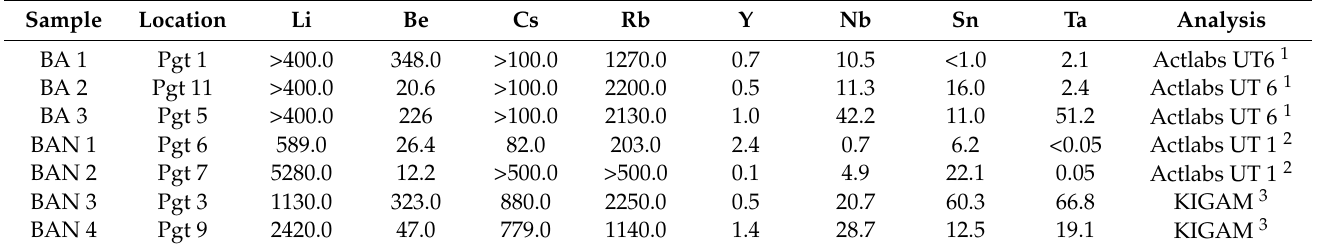
Table 1. Rare-element composition (ppm) of pegmatite samples from the Boam